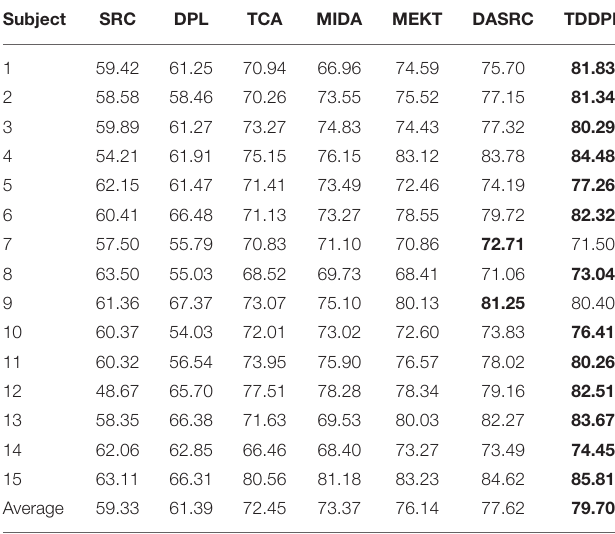
TABLE 3 | Average classification accuracies on session 1 of SEED dataset in the m → o scenario.